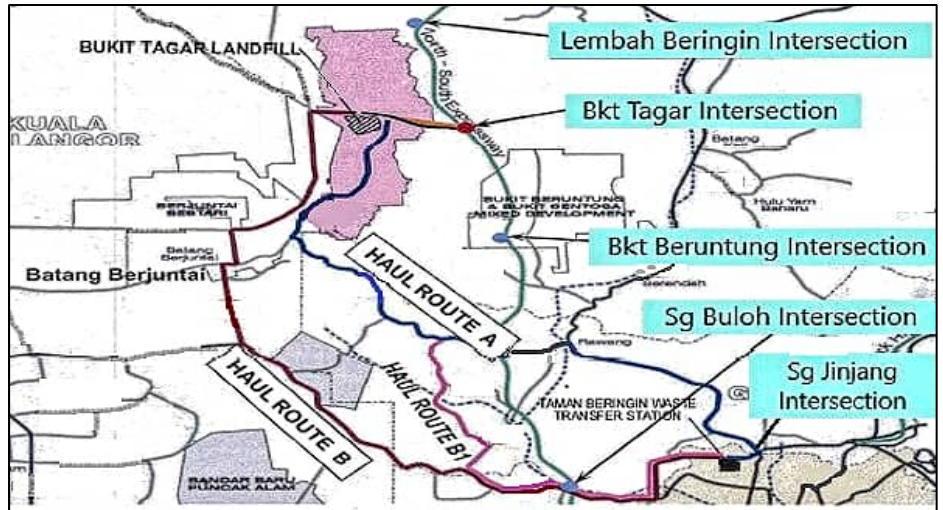
Figure 1. Route from Taman Beringin Solid Waste Transfer Station (TBSWTS). *Data from National Solid Waste Management Department (2012).